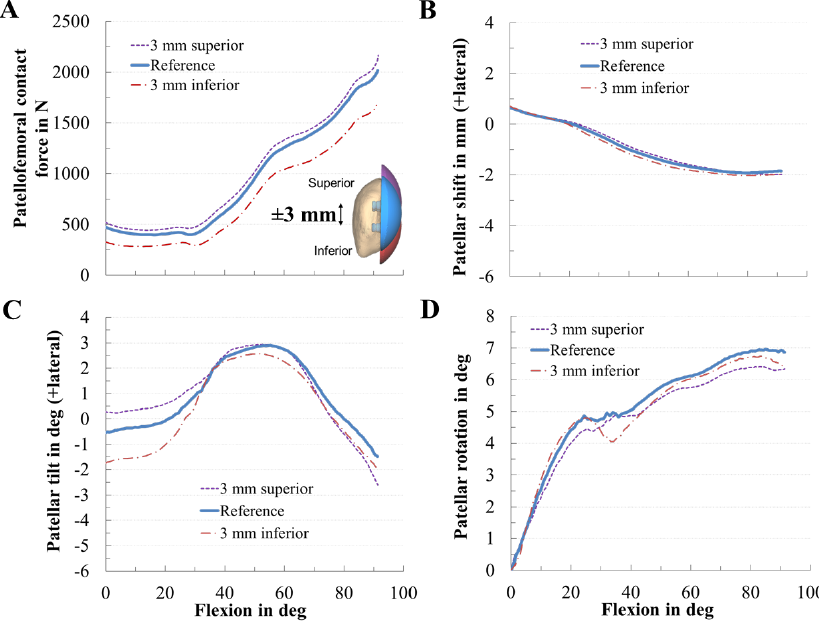
Figure 6. Effect of the superior–inferior positioning of the patellar component on patellofemoral dynamics. Effect of superior–inferior positioning of the patellar component on patellofemoral contact force ( A ), patellar shift ( B ), patellar tilt ( C ), and patellar rotation ( D ).